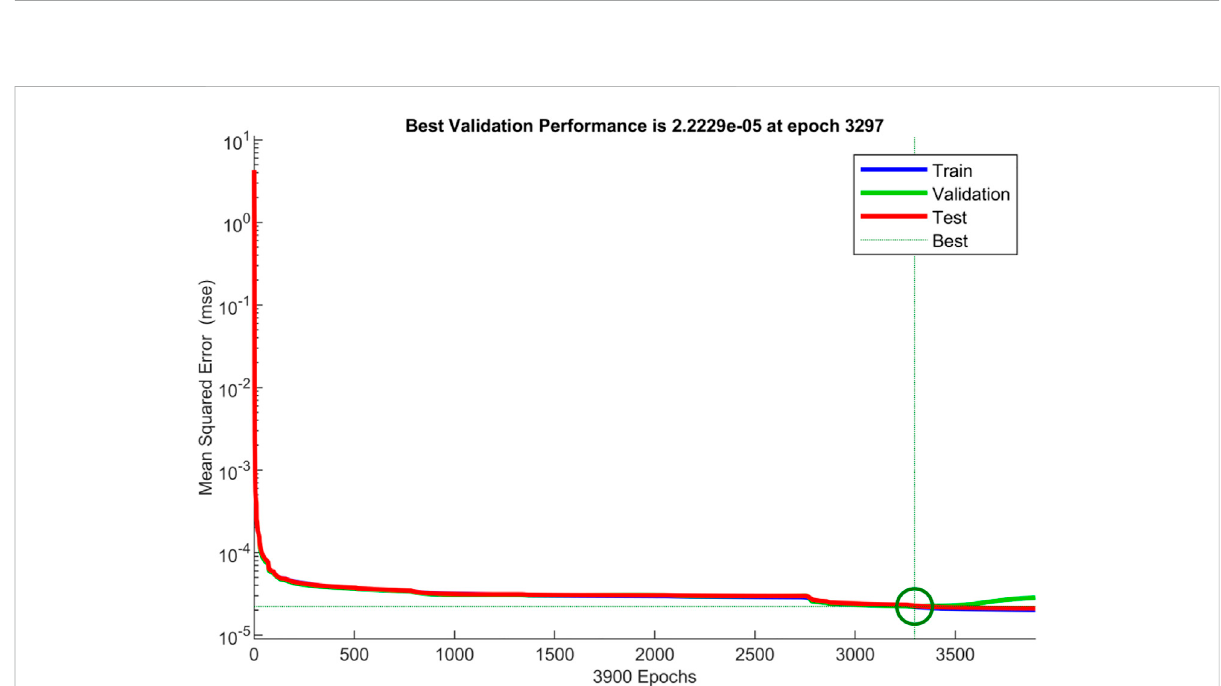
FIGURE 11 Training curve of the time series-based ANN checking model (TSANN) established for pressure of the primary-circuit